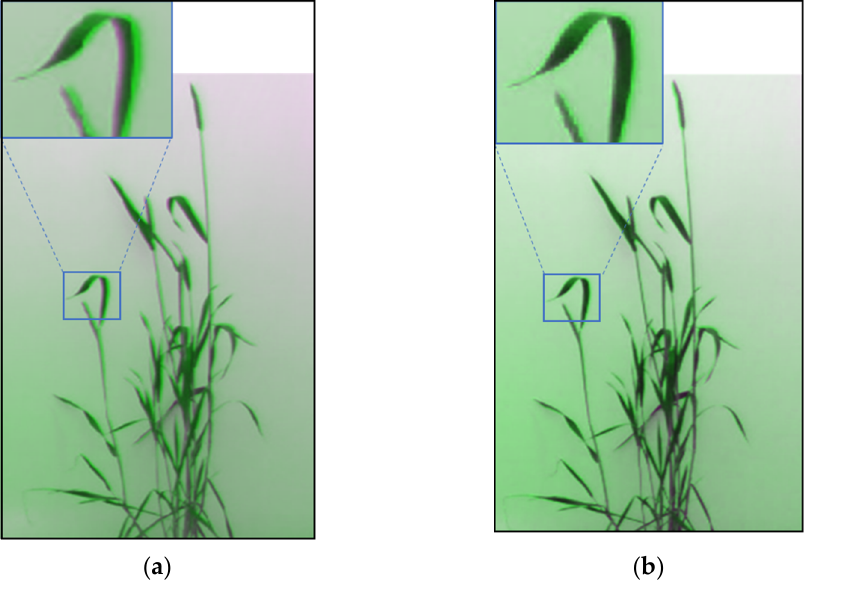
Figure 7. Image registration output after ( a ) coarse registration and ( b ) fine registration. Pink represents misalignment between the thermal and optical images, which was significantly reduced after fine